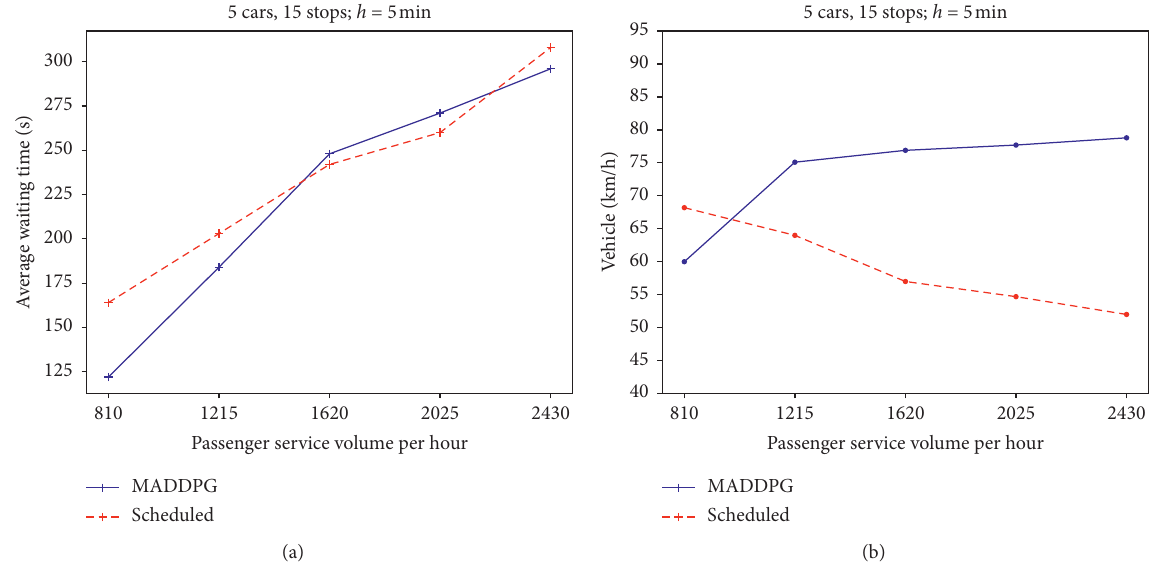
Figure 9: Performance comparison between the MADDPG and SCHEDULED methods in Scenario 3 based on the average passenger wait time and